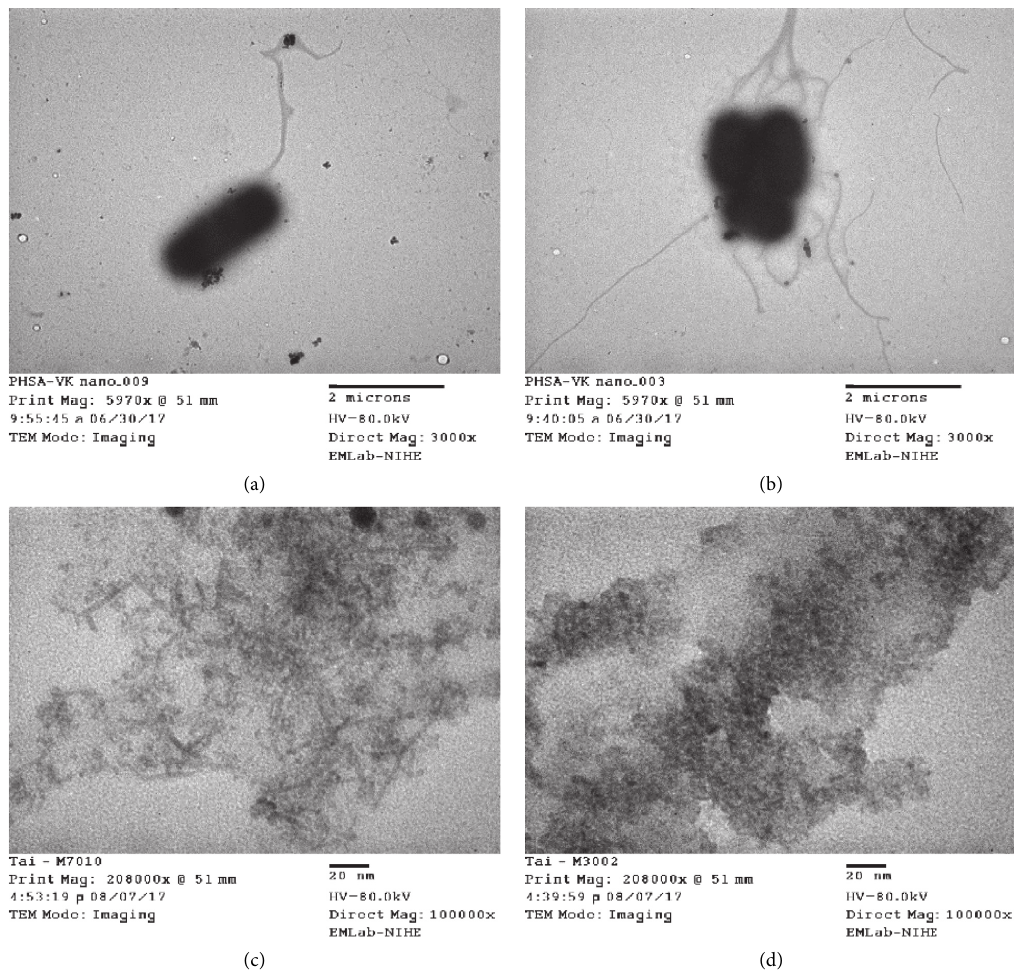
Figure 5: TEM images of E. coli and MRSA with CSQDs (a, b) and without CSQDs (c,